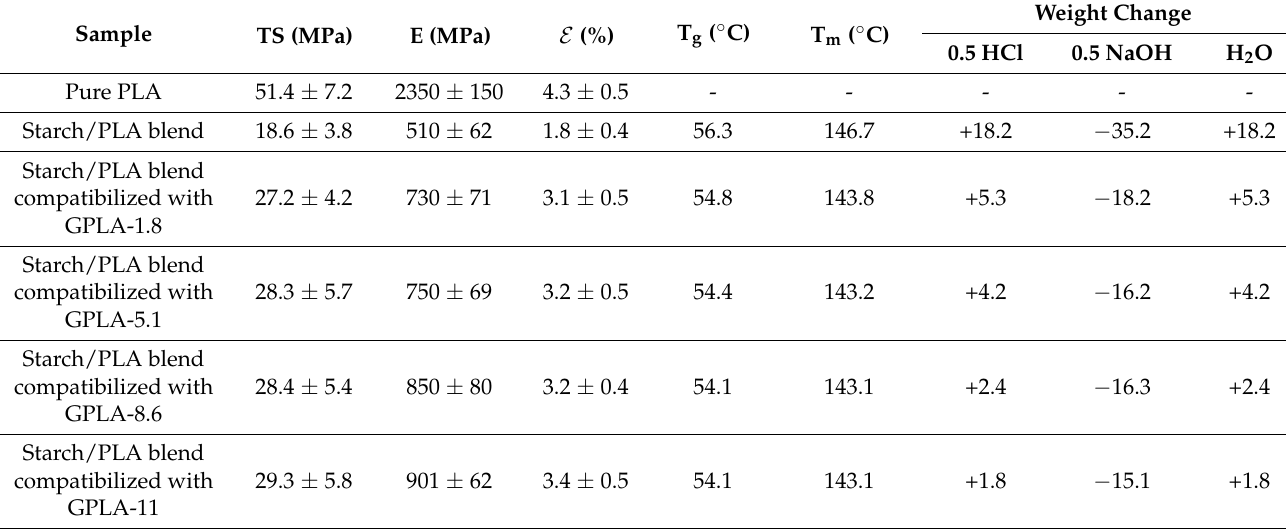
Table 6. Summary of the comparison of properties of Starch/PLA (50/50) blends compatibilized with GPLA